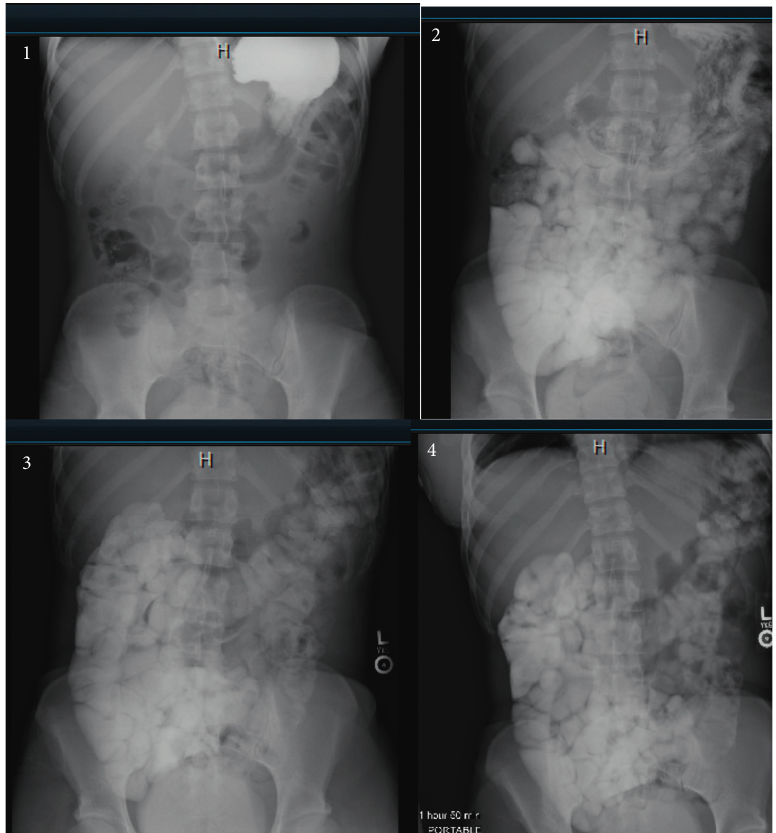
Figure 3: Upper gastrointestinal study with small bowel follow-through revealing no acute obstruction (radiographic images taken in series and are exhibited chronologically from